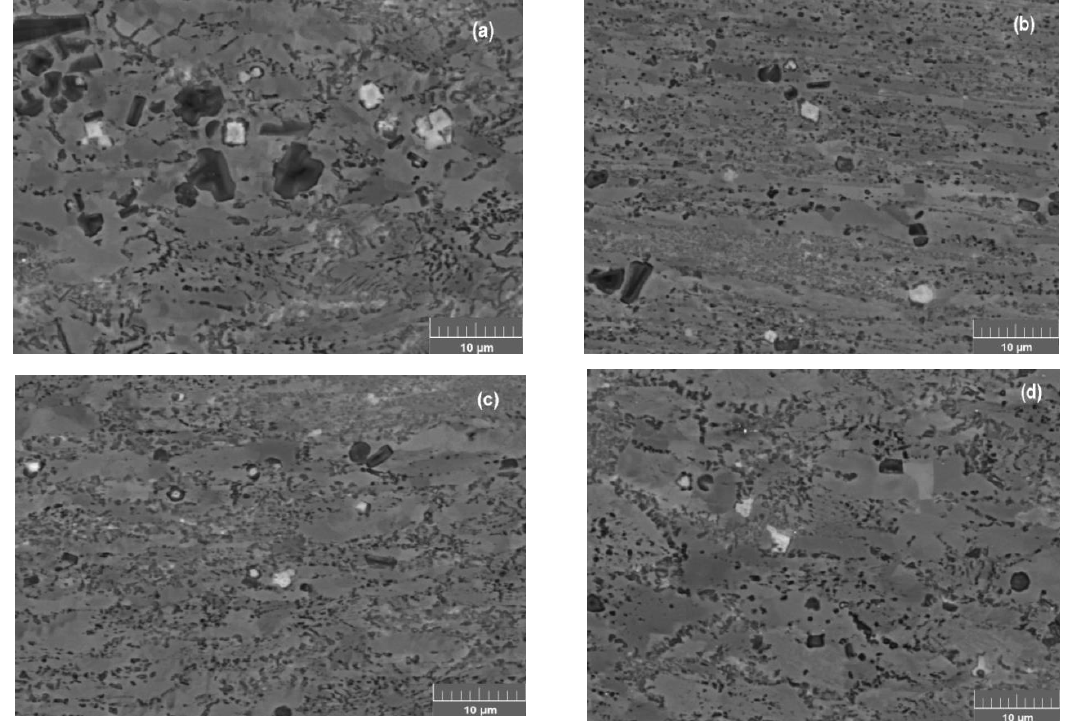
Figure 5. Microstructure of the Fe – 16Cr – 4Ti – 6Zr – 3.2B steel after hot deformation: 1373 K, 1 s − 1 ( a );